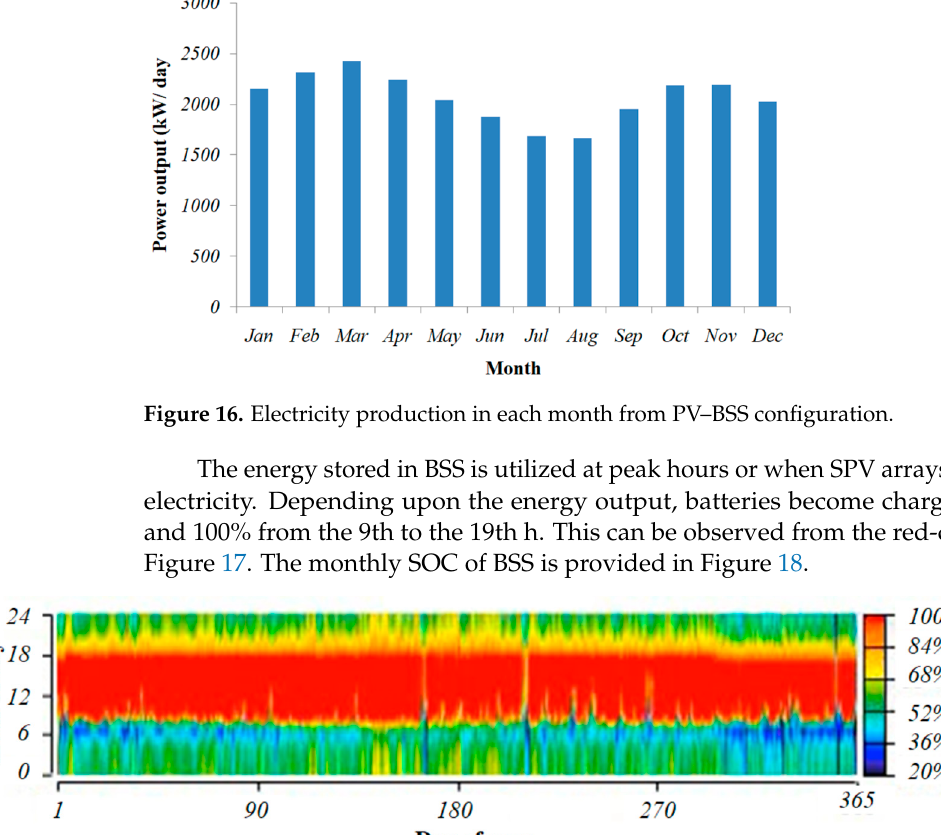
Figure 15. SPV array power output for the PV–BSS configuration.